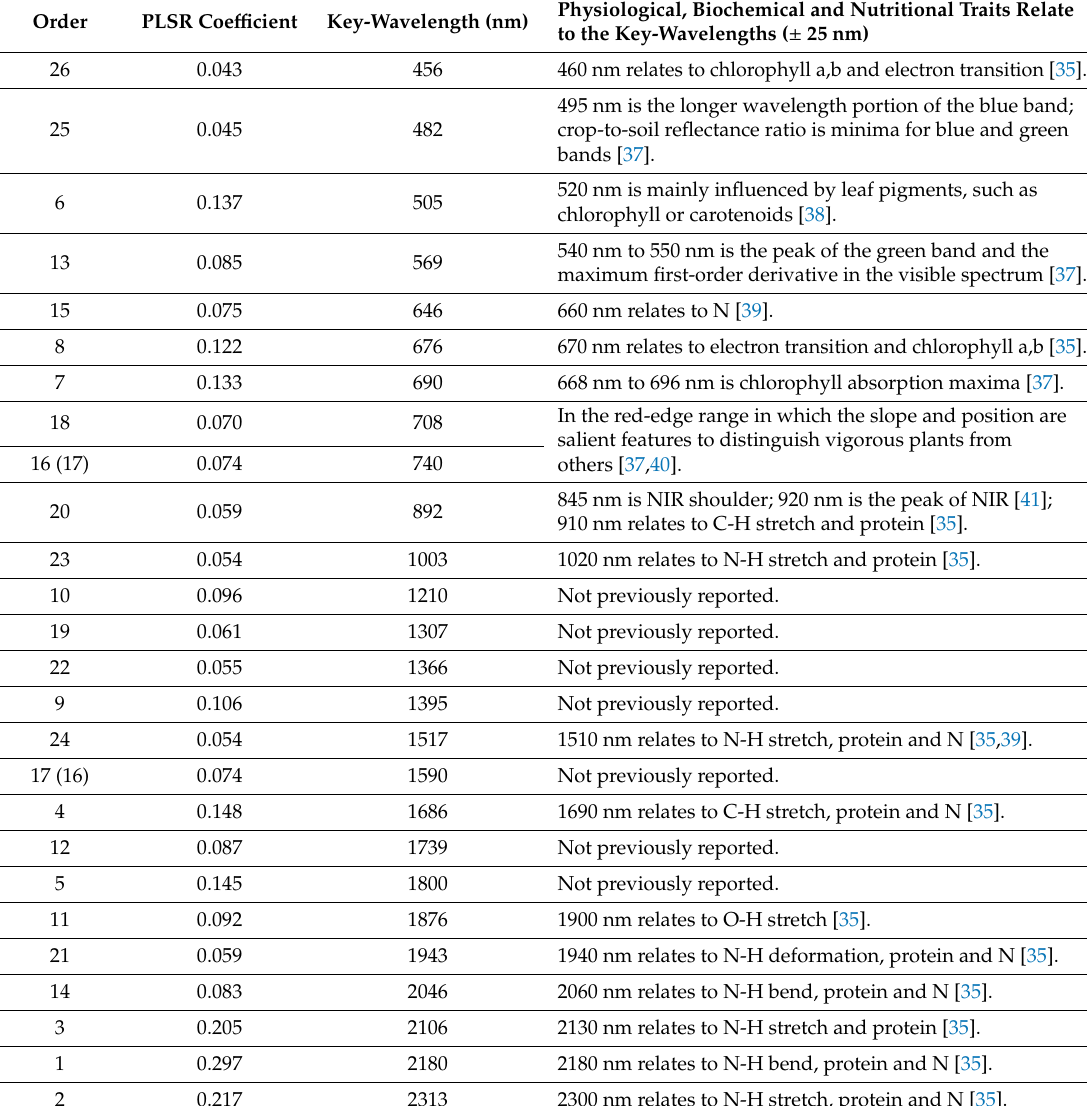
Physiological, biochemical and nutritional traits reported previously related to the key-wavelengths identified in this